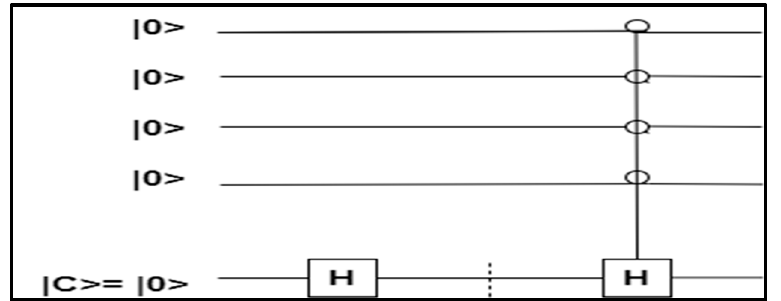
datapoint belongs to label 1 or centroid